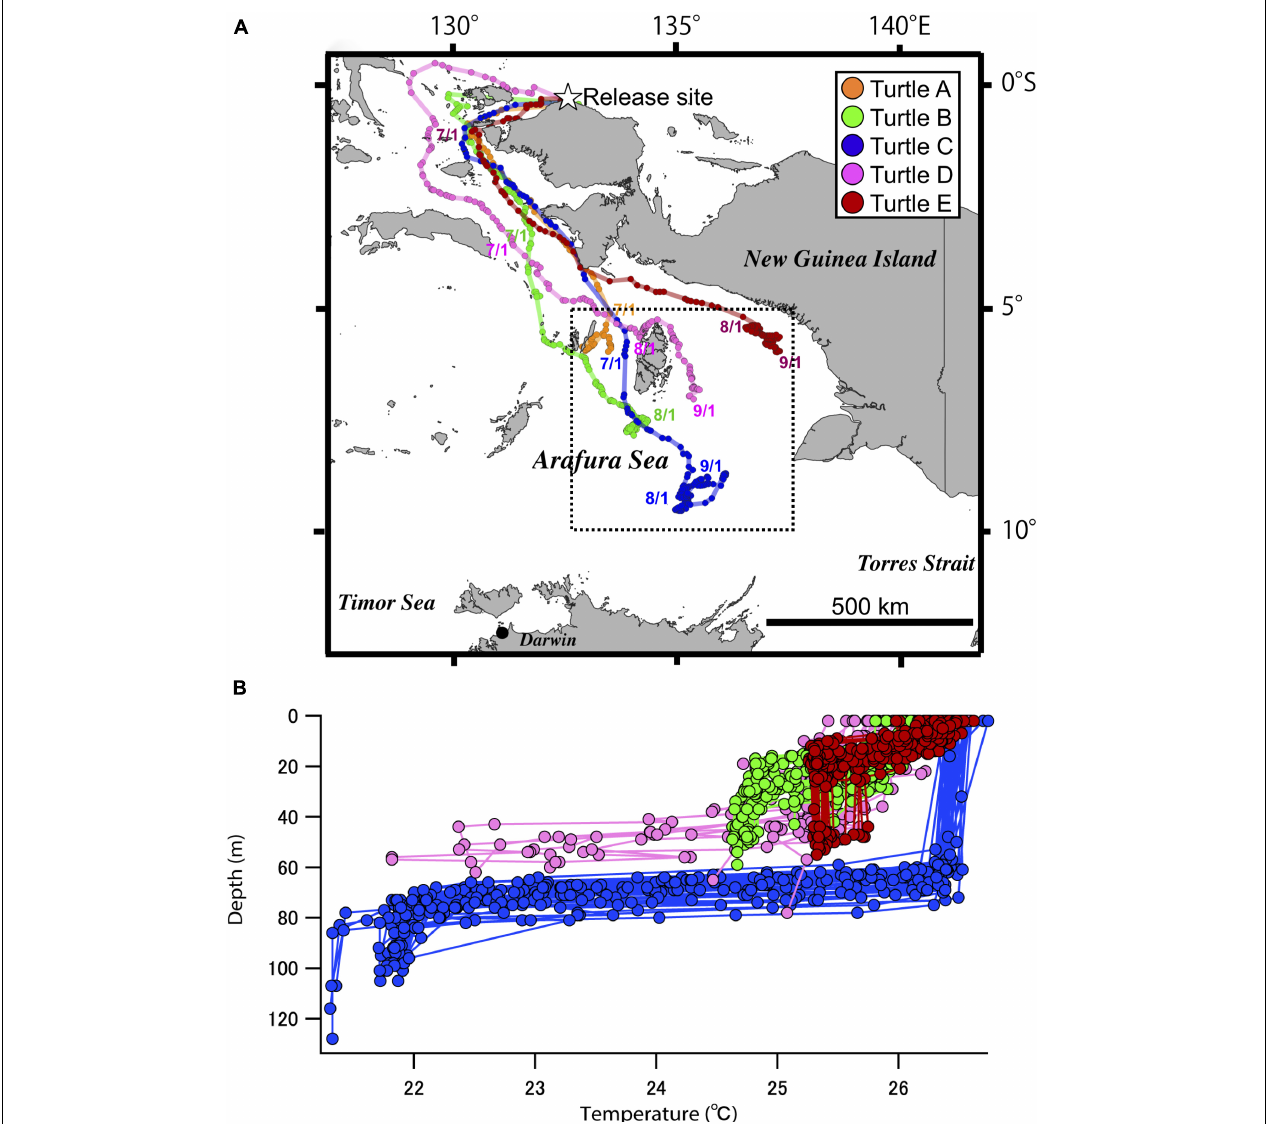
FIGURE 1 | (A) Migration routes of the five olive ridley turtles from June to October 2017. Each color indicates each individual, and color circles indicate the position where depth-temperature profiles were transmitted. (B) Depth–temperature profiles obtained from turtles in the region of 133 ◦ –138 ◦ E, 10 ◦ –5 ◦ S (shown by black dotted box in panel A ) during the period from July 27 to August 6, 2017. The colors are the same as (A)